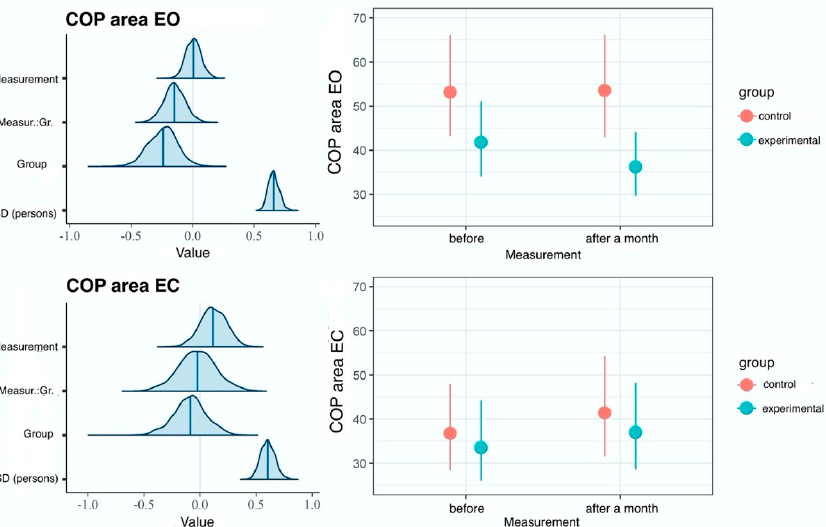
Figure 8. Results of hierarchical two-dimensional regression analysis: the dependent variable is the COP-SA, whereas the predictors are the dependent variable and the group. Left panels: a posteriori distributions of regression coefficients. Shaded areas denote 95% confidence level. Right panels: estimated marginal means. The points denote a posteriori distribution mean values, and vertical lines represent 95% confidence intervals. COP—center of pressure; EO—eyes open; EC—eyes closed; Measur.:Gr.—Measurement: Group.